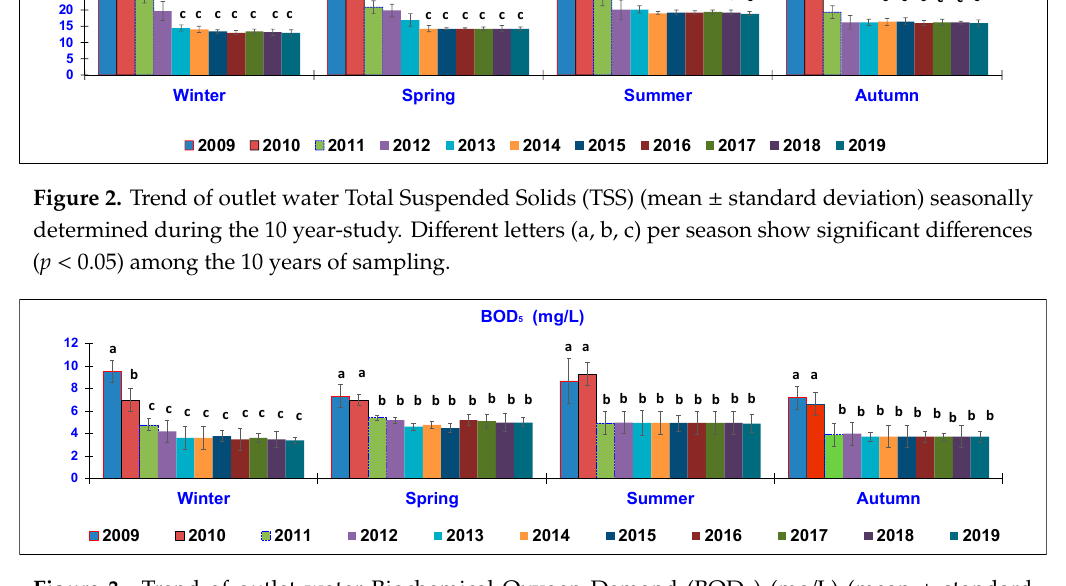
Figure 3. Trend of outlet water Biochemical Oxygen Demand (BOD ₅ ) (mg/L) (mean ± standard deviation) seasonally determined during the 10 year-study. Different letters (a, b, c) per season show significant differences ( p < 0.05) among the 10 years of sampling.